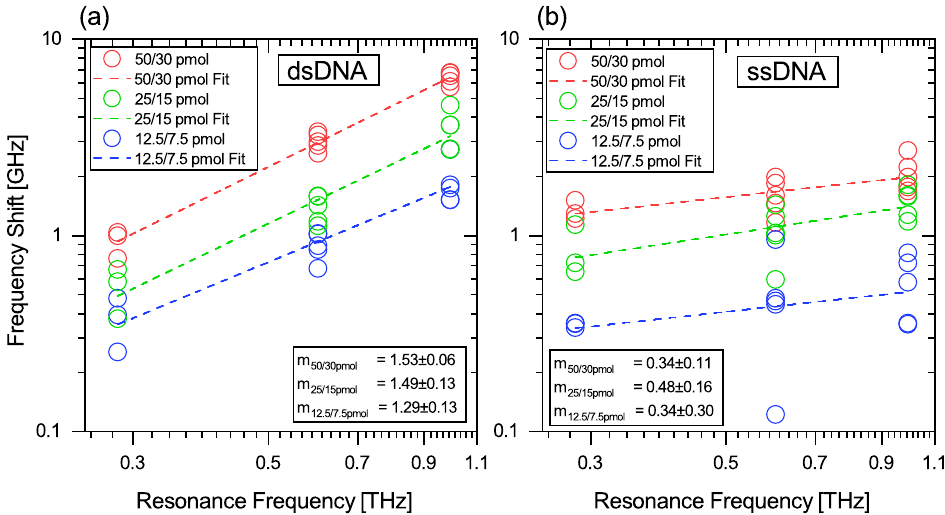
Figure 5. Negative frequency shift as a function of the resonance frequency for ( a ) dsDNA and ( b ) ssDNA. The frequency shift is fitted with a linear function on the double logarithmic scale and indicated in dashed lines for sample amounts of 50/30pmol in red, for 25/15pmol in green and for 12.5/7.5pmol in blue. The parameter m describes the slope of the fit function. The first number of the amount of substance indicates the used sample material for the 0.3THz sensors and the second number for 0.6THz and 1THz,